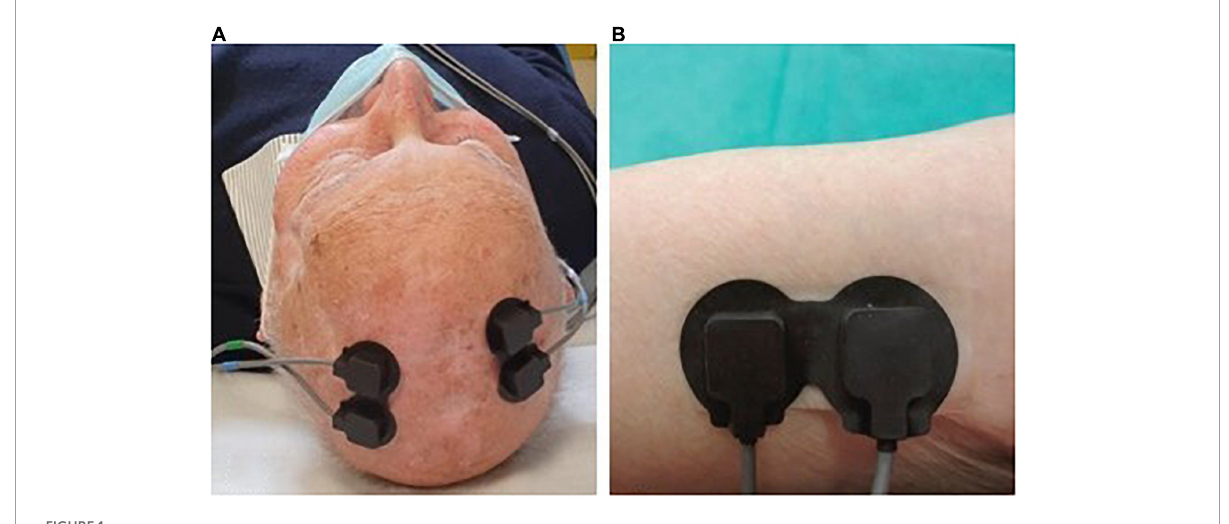
FIGURE1 Example of positioning the probes on Aks (A) and on healthy skin (B)